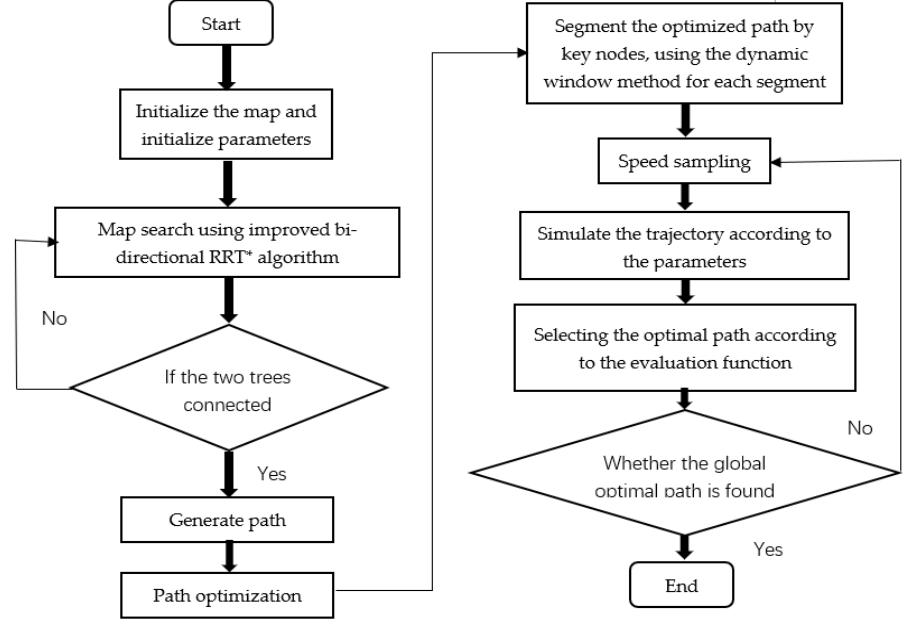
Figure 12. Flow chart of fusion algorithm.